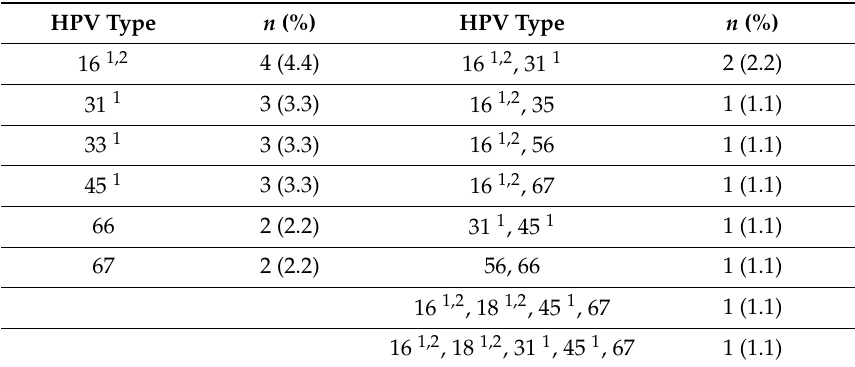
Table 2. Distribution of high-risk HPV